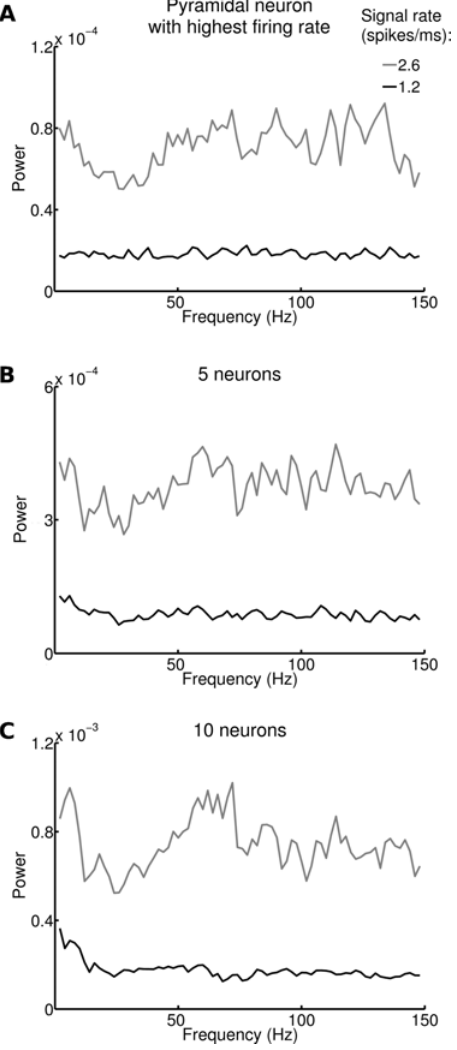
Figure 5. Spectral modulations associated to changes in stimulus rate in ensembles of a small number of neurons. (A) Power spectrum of firing of pyramidal neuron with highest firing rate when the signal rate is 1.2 and 2.6 spikes/ms. Averages over 20 trials displayed in black and gray, respectively. (B–C) Same as (A) for the total firing rate of the 5 and 10 pyramidal neurons with highest firing rates, respectively. Notice the difference in the power scale.